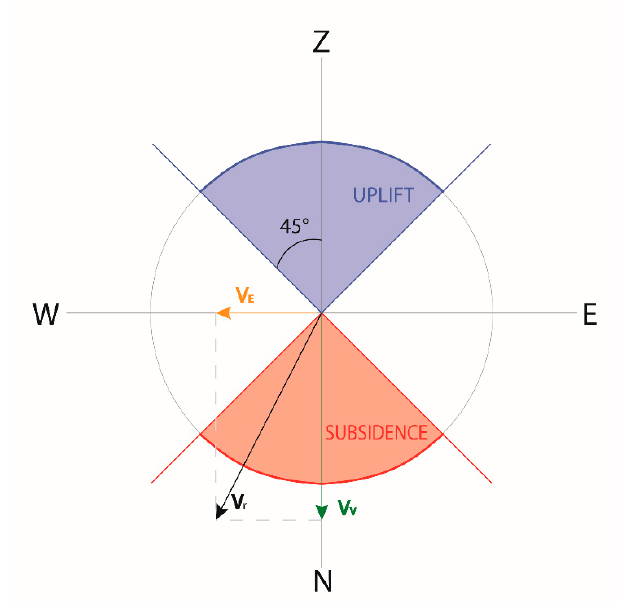
Figure 4. Filtering of the data. E: East, W: West, Z: Zenith, and N: Nadir (from [35]).